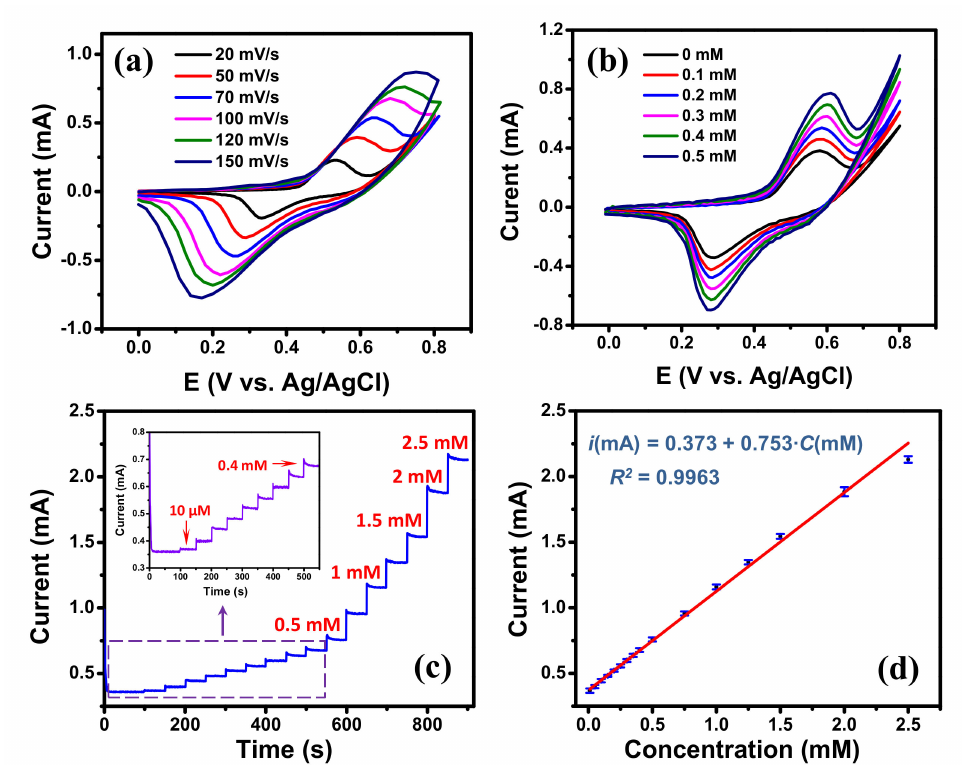
Figure 5. ( a ) Cyclic voltammograms of the graphene/Ni hybrid mesh V-50 electrode at different scan rates in 0.1 M NaOH; ( b ) cyclic voltammograms of the graphene/Ni hybrid mesh V-50 electrode under different glucose concentrations (scan rate: 50 mV · s − 1 ); ( c ) Amperometric responses of the graphene/Ni hybrid mesh V-50 electrode with addition of glucose every 50 s at 0.6 V, (insert show the magnification of low glucose concentration) with scan rate of 50 mV · s − 1 ; ( d ) Linear calibration curve of current response vs. glucose